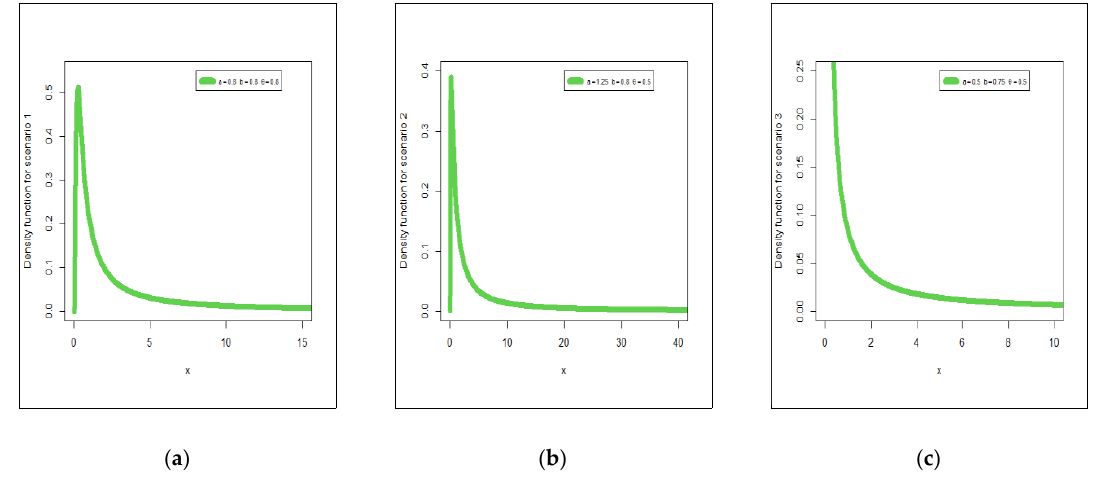
Figure 1. Density functions for the three scenarios.